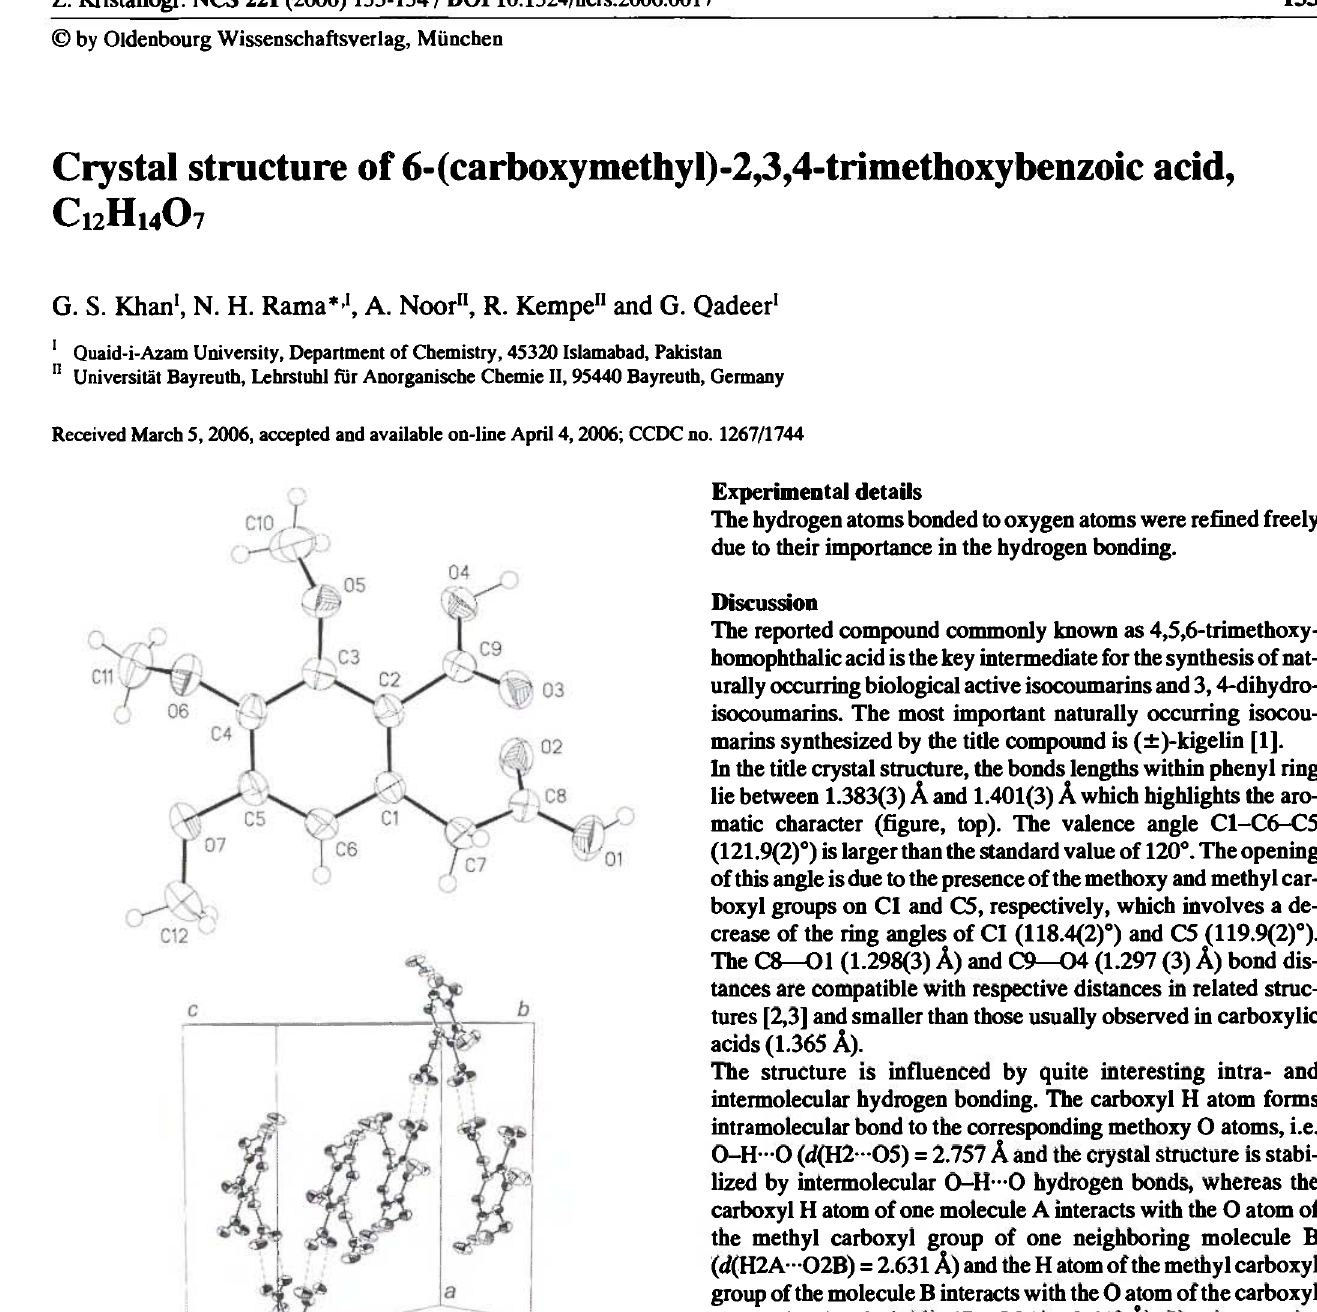
Table I. Data collection and handling.